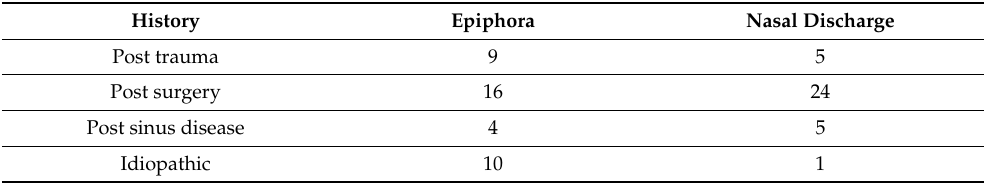
Table 4. Number of cases reported with epiphora and nasal discharge in 105 equine cases of suture exostosis divided according to history of